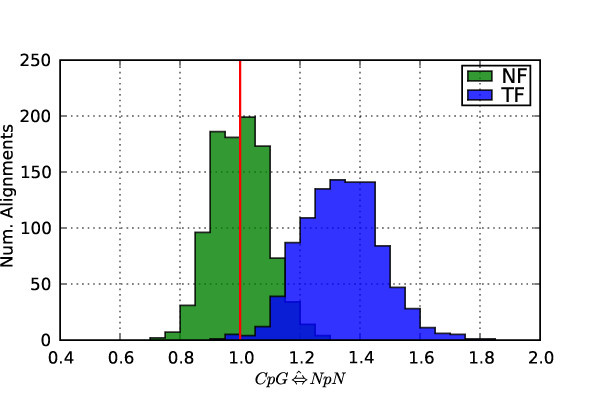
Context effects are detected using TF when none exist. Sequences were simulated under a nucleotide GTR model with π (A) + π (T) ≈ 0.6. A single dinucleotide parameter for CG ⇔ NN was added to the TFnuGTR and NFnuGTR dinucleotide baseline models. The red vertical line represents the expected value under the null hypothesis (the parameter has no effect). x-axis is the MLE of CG ⇔ NN, y-axis is the number of simulated alignments.